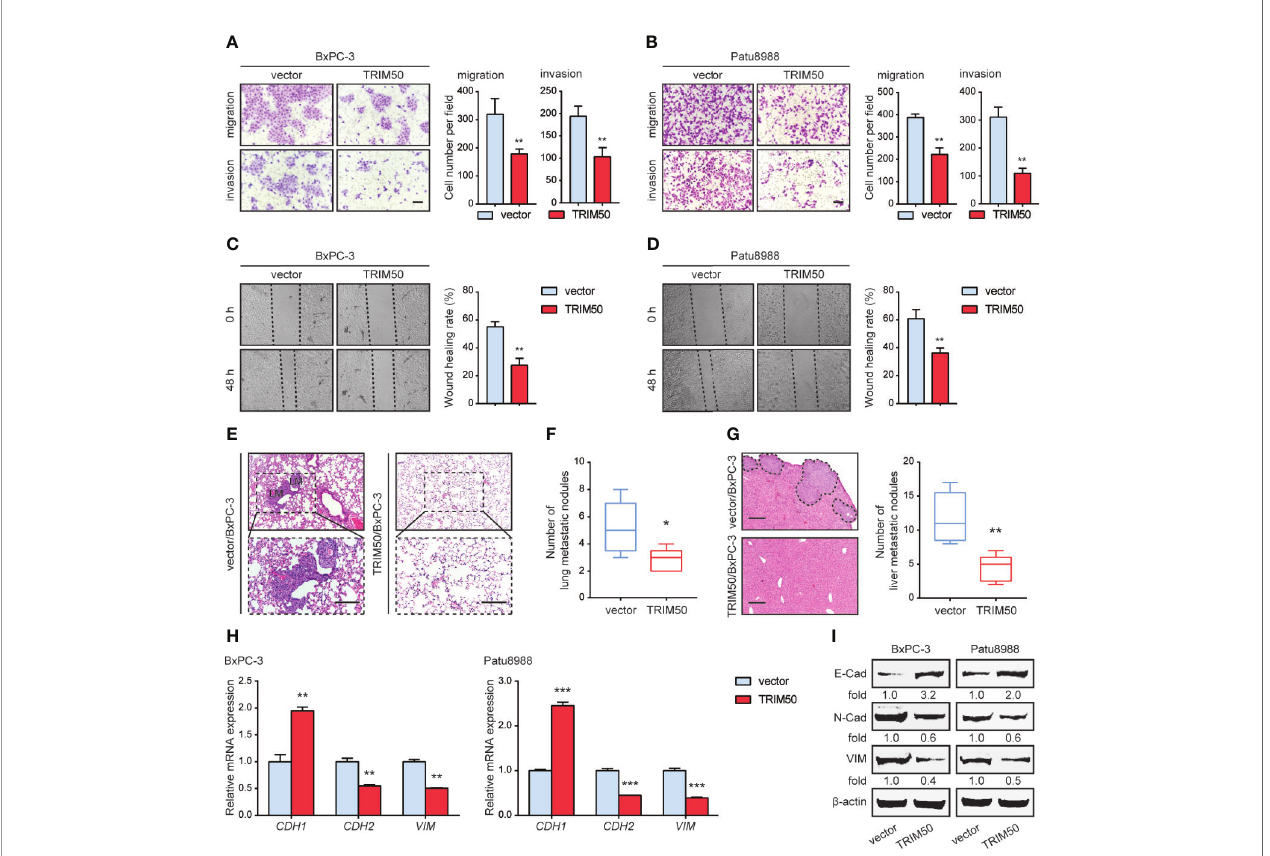
FIGURE 3 | TRIM50 overexpression inhibited cell migration, cell invasion, and lung metastasis in pancreatic cancer. (A, B) The effect of TRIM50 overexpression on cell migration and invasion of BxPC-3 (A) and Patu8988 (B) cells revealed by Transwell assays. Scale bar: 50 m m. (C, D) The effect of TRIM50 overexpression on cell mobility of BxPC-3 (C) and Patu8988 (D) cells revealed by wound healing assay. (E) TRIM50-overexpressing and vector control BxPC-3 cells were injected into the tail vein of nude mice (5 per group). Representative H&E images of lung metastasis (LM). Scale bar: 50 m m. (F) Quanti fi cation of lung metastasis after 5 weeks after injection. (G) TRIM50-overexpressing and vector control BxPC-3 cells were injected into the spleen of nude mice (5 per group). Representative H&E images of liver metastasis (left panel), quanti fi cation of liver metastasis after 5 weeks after injection (right panel). Scale bar: 200 m m. (H, I) The effect of TRIM50 overexpression on the expression of EMT-related markers, E-Cadherin (E-Cad), N-Cadherin (N-Cad), and Vimentin (VIM), con fi rmed by qRT-PCR (H) and western blotting (I) . * P < 0.05, ** P < 0.01, and *** P <